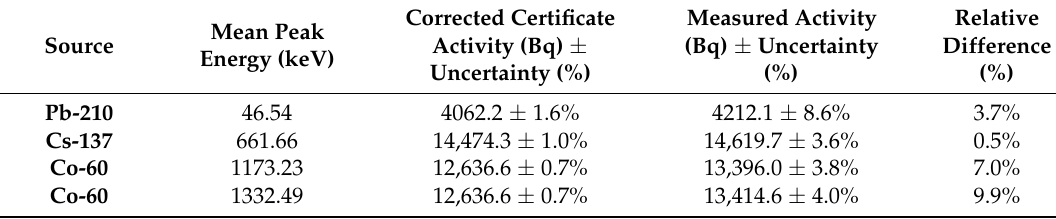
Table 5. Comparison of the certificate activity (corrected for the time of measurement) and the activity calculated from measurement with the verification